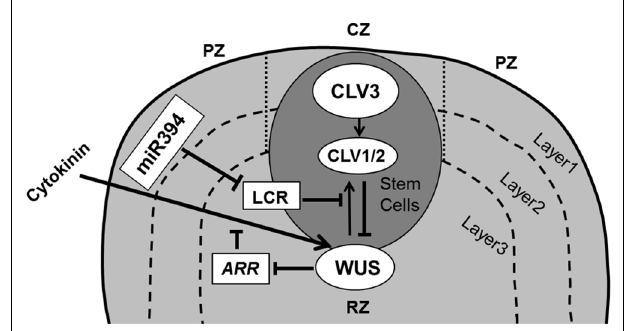
FIGURE 2 | Maintenance of stem cells in shoot apical meristem. The SAM is organized in three functional zones [central zone (CZ), peripheral zone (PZ), and rib zone (RZ)] and three layers where the antagonistic relation betweenWUS and CLV is essential to preserve cells in the meristem.WUS activates CLV3, which further binds with CLV1/2 and in turn inhibits expression of WUS . Cytokinin positively controls WUS expression where ARRs are negative regulators of cytokinin and are inhibited byWUS. The L1 specific miR394 negatively affects the LCR protein, which interferes in WUS/CLV based stem cell maintenance (pointed andT shaped arrows indicate positive and negative regulation, respectively).